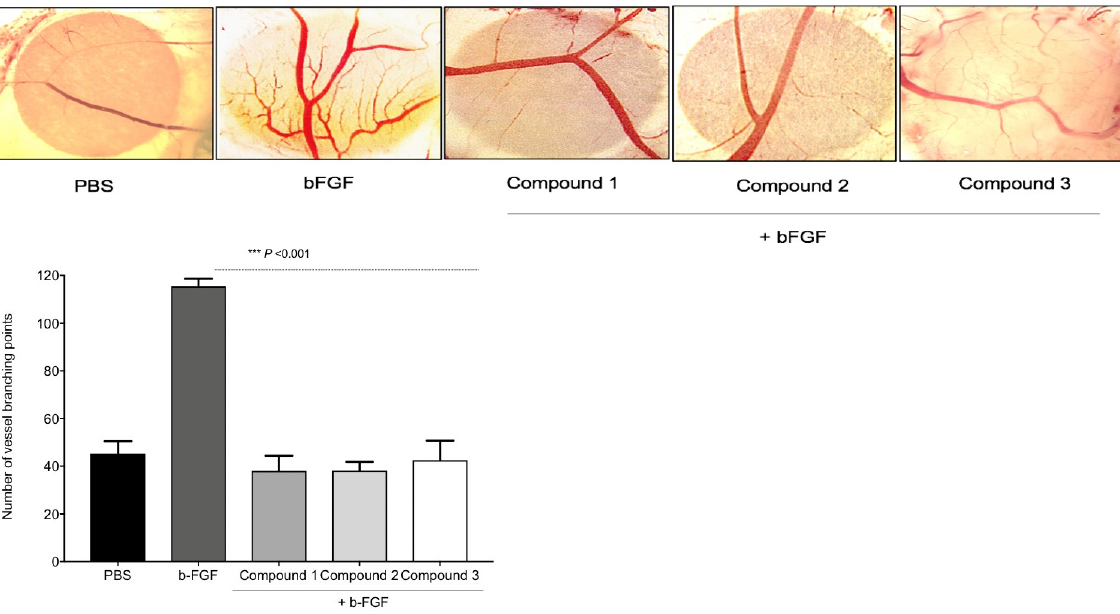
Figure 5. Inhibition of angiogenesis in chick chorioallantoic membrane (CAM). With the development of small new blood vessels, typical neovascularization was visible with CAM assay. ( A ) Images represent the inhibition of the b-FGF (10 ng/CAM)-induced angiogenesis by Compounds 1 , 2 , and 3 at 1 µ g/CAM. ( B ) Data illustrate the decrease of compounds. Values are presented as the mean ± S.D *** p < 0.001, compared to the